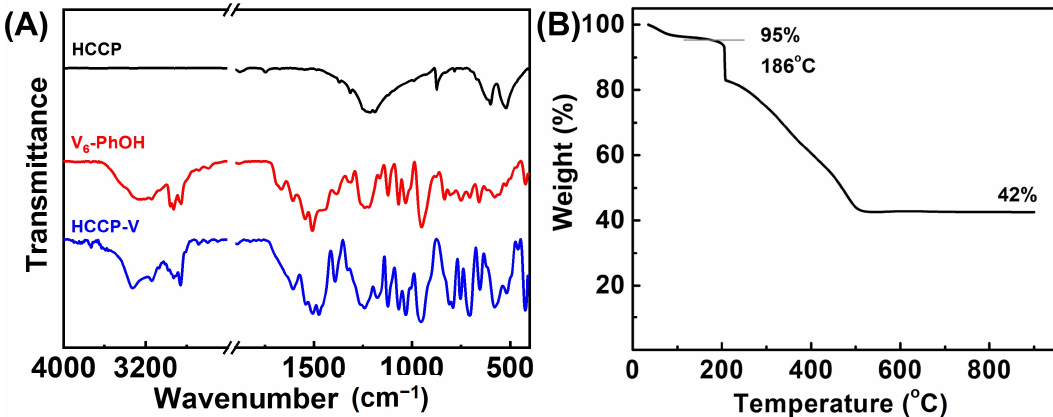
Figure 1. The FT-IR spectra ( A ) and TGA curve in O 2 ( B ) of HCCP-V.